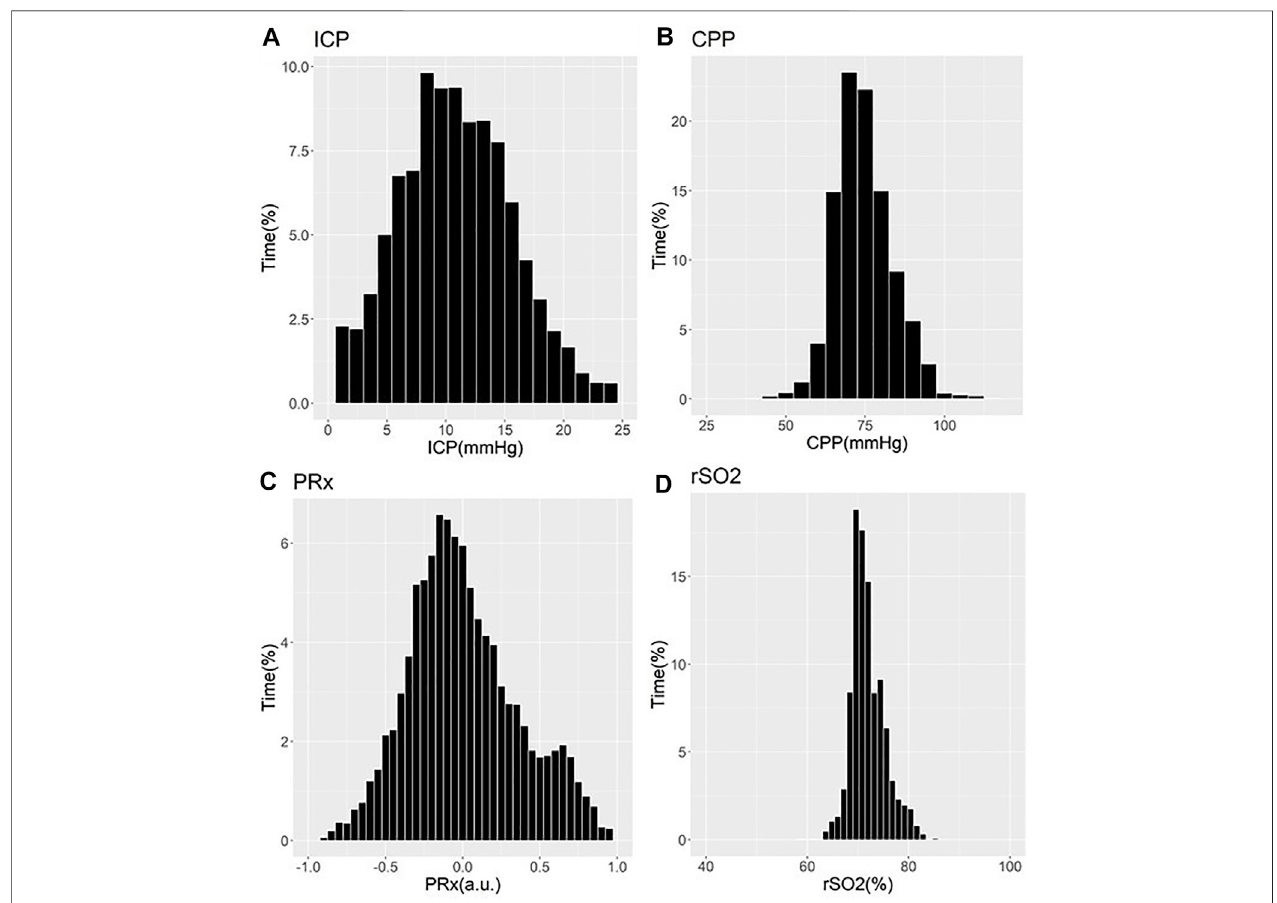
FIGURE 1 | Example of Cerebral Physiology in Severe TBI – 24 Year Old Patient – First 72 Hours of ICU Stay. a. u. (cid:1) arbitrary units, CPP (cid:1) cerebral perfusion pressure, ICP (cid:1) intracranial pressure, ICU (cid:1) intensive care unit, mmHg (cid:1) millimeters of Mercury, MAP (cid:1) mean arterial pressure, PRx (cid:1) pressure reactivity index (correlation between slow-wave of ICP and MAP), rSO 2 (cid:1) regional cerebral oxygen levels (Rt Frontal). Panel (A) (cid:1) histogram of ICP and % time of recorded physiology, Panel (B) (cid:1) histogram ofCPP and % time ofrecorded physiology, Panel (C) (cid:1) histogram ofPRx and %time ofrecorded physiology, Panel (D) (cid:1) histogram of rSO 2 and % time of recorded